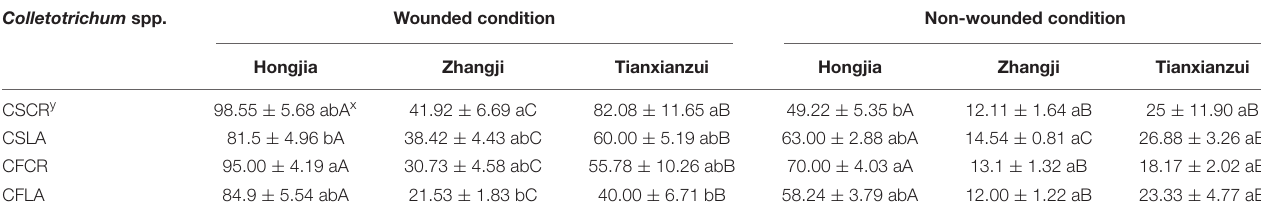
TABLE 5 | The disease index of Colletotrichum species from leaf and crown of strawberry toward crowns of different strawberry varieties. Colletotrichum